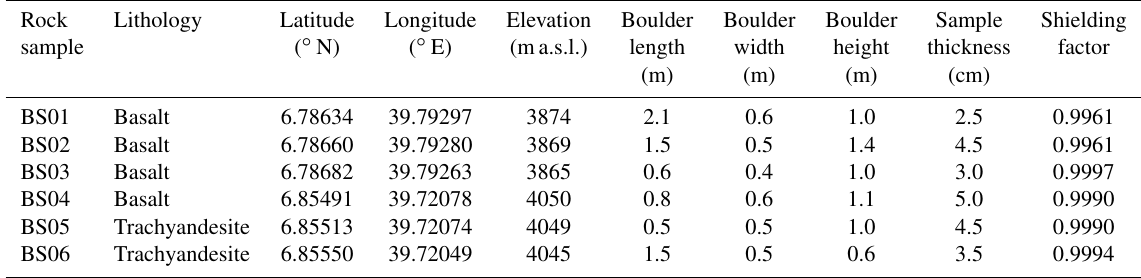
Data from Groos et al. (2021).